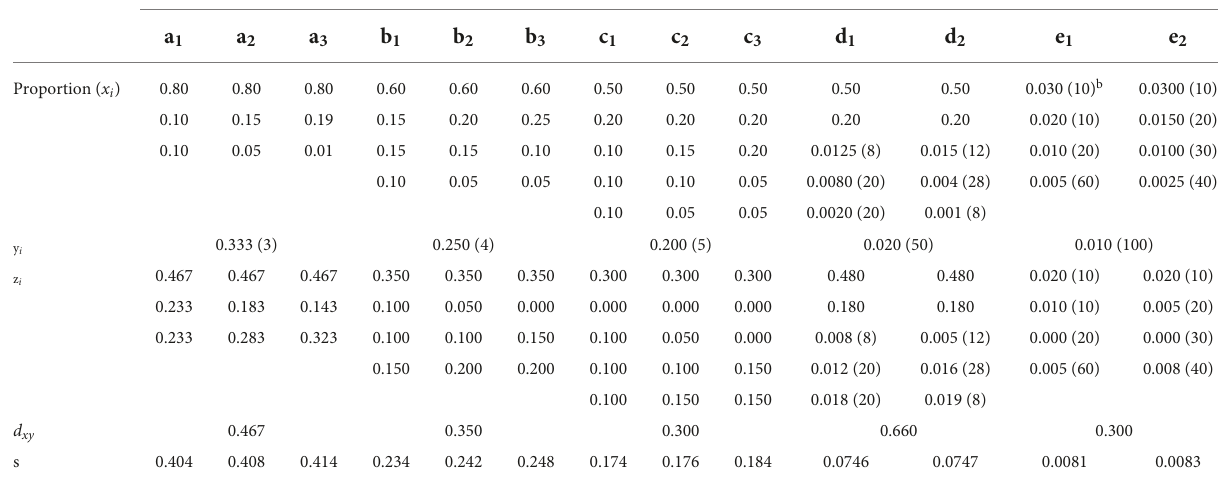
TABLE 1 Frequency distributions of different simulated communities with the same absolute discrepancy ( d xy ). Simulated communities a